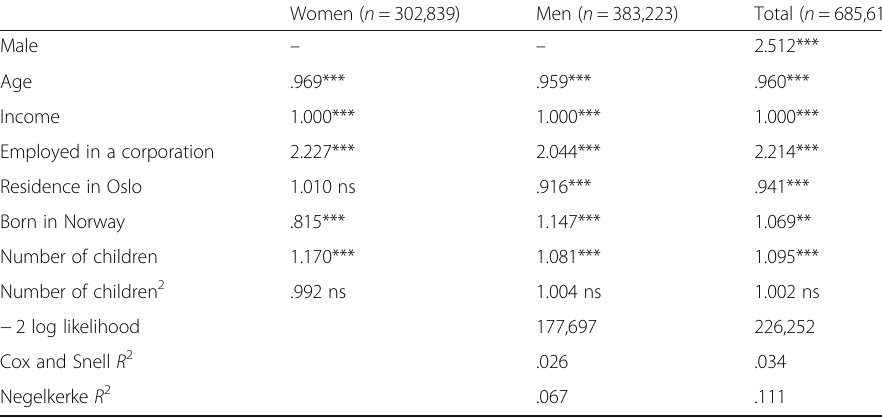
Table 5 Prediction of entry into business ownership